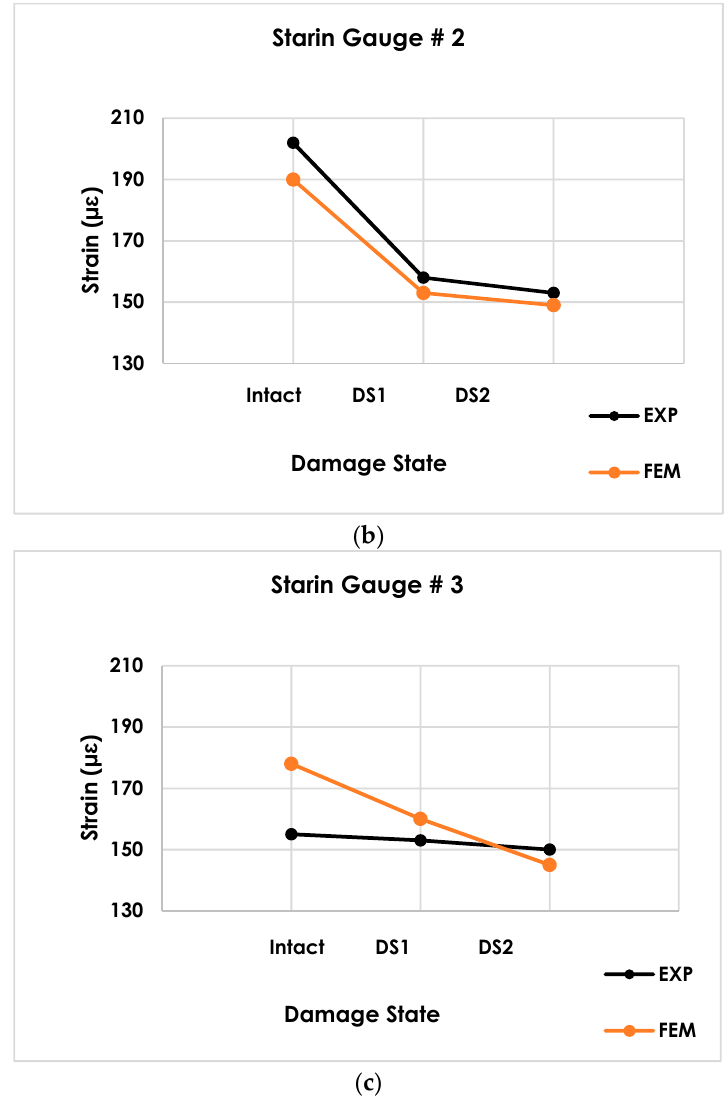
Figure 3. A comparison of the maximum strain measured by the strain gauges. (a) strain gauge # 1 (b) strain gauge # 2, and (c) strain gauge # 3